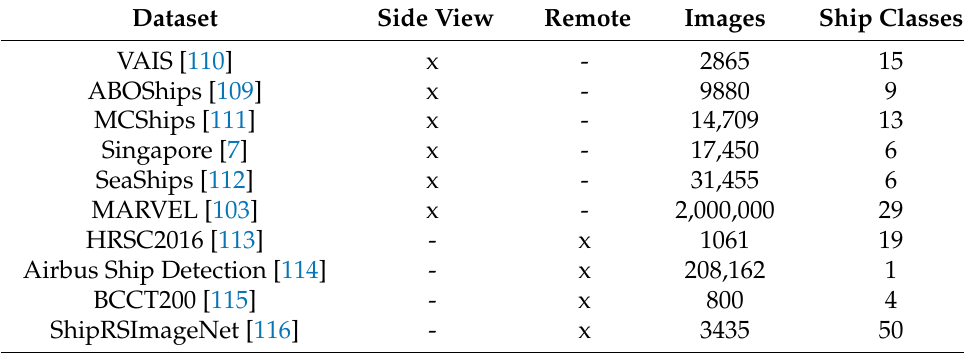
Table 3. Remote and side view ship